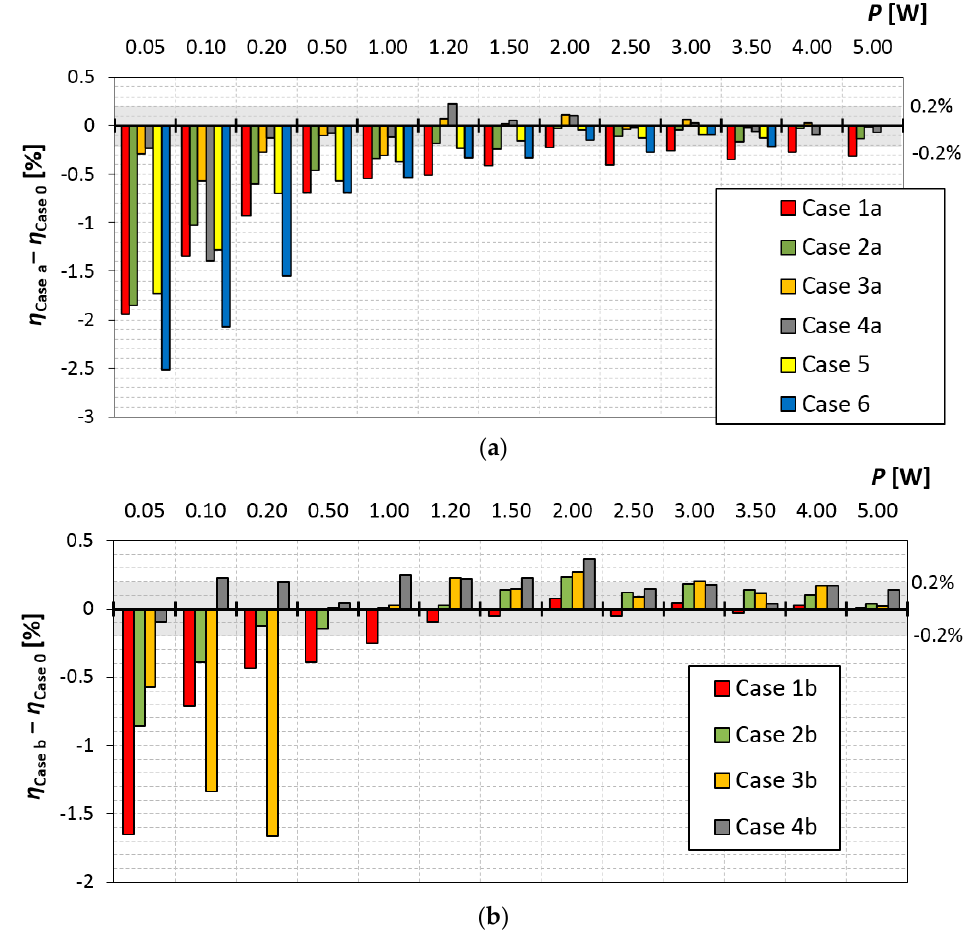
Figure 6. Efficiency differences between case 0 and cases a ( a ) and b ( b ).